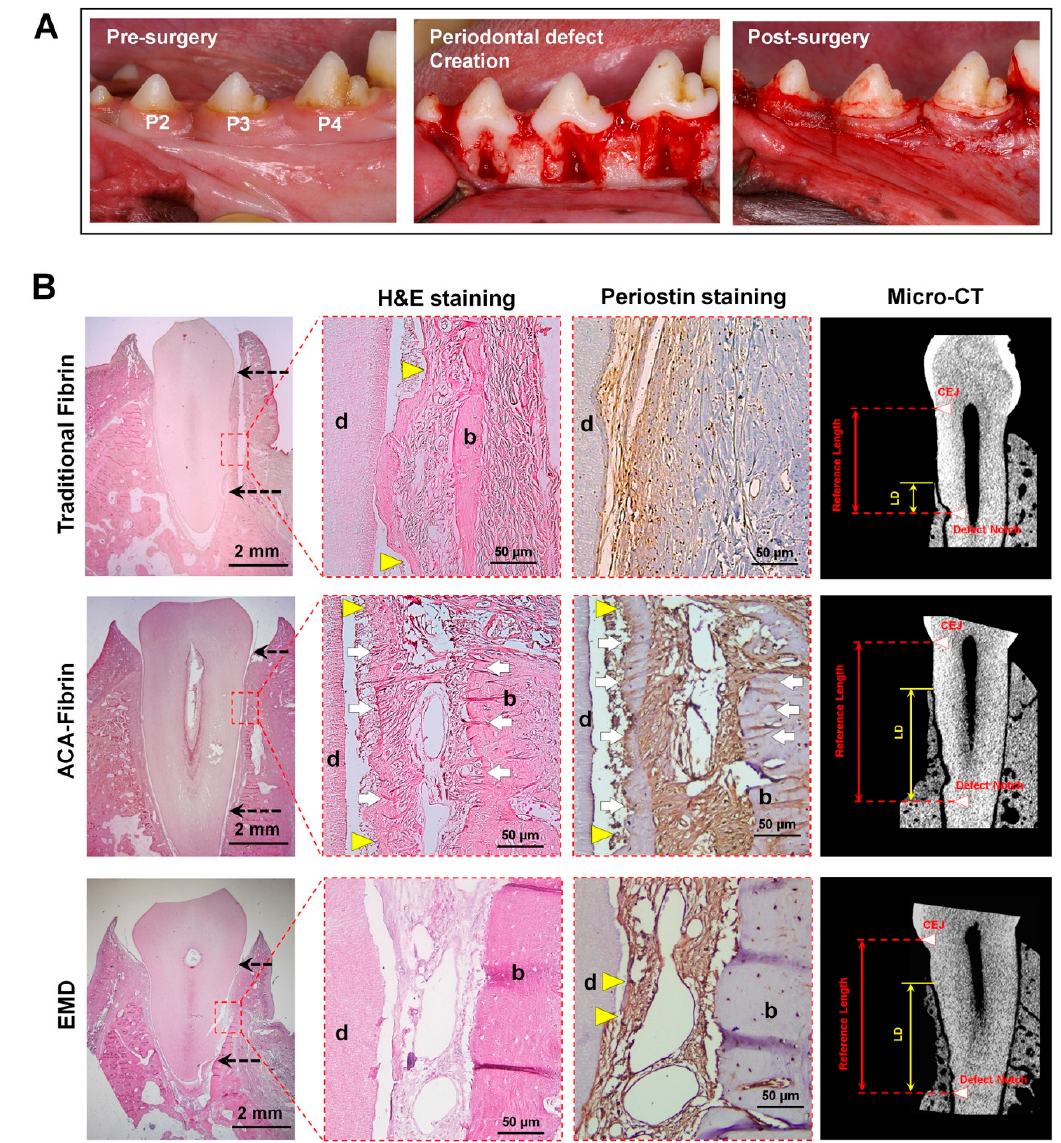
Figure 7. Fibrin fabrication to promote periodontal mineralized tissue formations; osteogenesis and cementogenesis. Using the canine model, the periodontal defects around the tooth-root surfaces were surgically created and biomaterials were transplanted (traditional fibrin, ε -aminocaproic acid (ACA) modified fibrin (ACA-fibrin), and enamel matrix derivative (EMD)) ( A ). For morphological analyses with Sharpey’s fiber insertion, hematoxylin and eosin (H&E) staining and periostin staining methods were utilized ( B ). In particular, cementum regeneration with Sharpey’s fiber anchorages could be significantly found in the ACA-fibrin group even though the alveolar bone formation showed in both ACA-fibrin and EMD groups ( B ). (black dash arrow: surgically created defect, yellow triangle: cementum layer, white arrow: Sharpey’s fiber, d: dentin, b: bone, LD: linear distance of bone regeneration (root coverage), CEJ: cementoenamel junction). Adapted with permission from the reference [14].